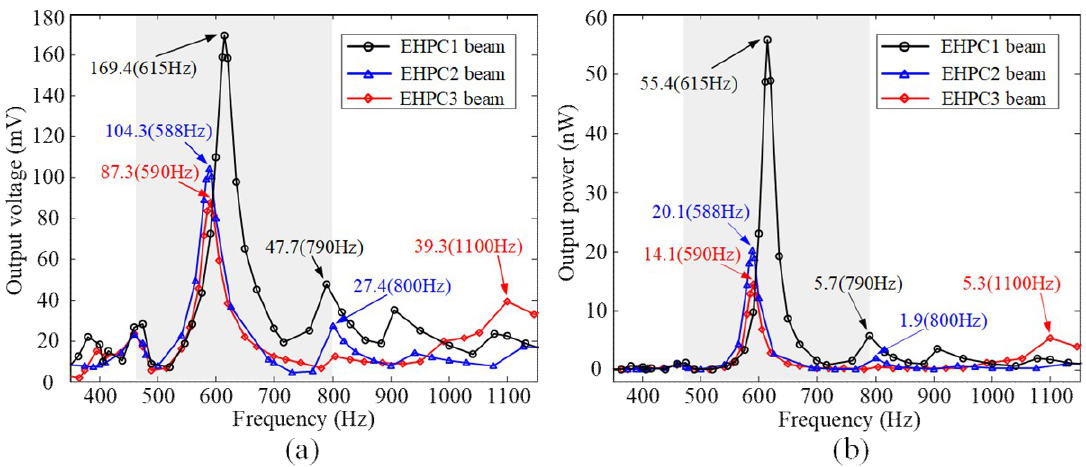
Figure 7. Experimental energy harvesting results around the first defect mode: ( a ) output voltage and ( b ) output power (color online).